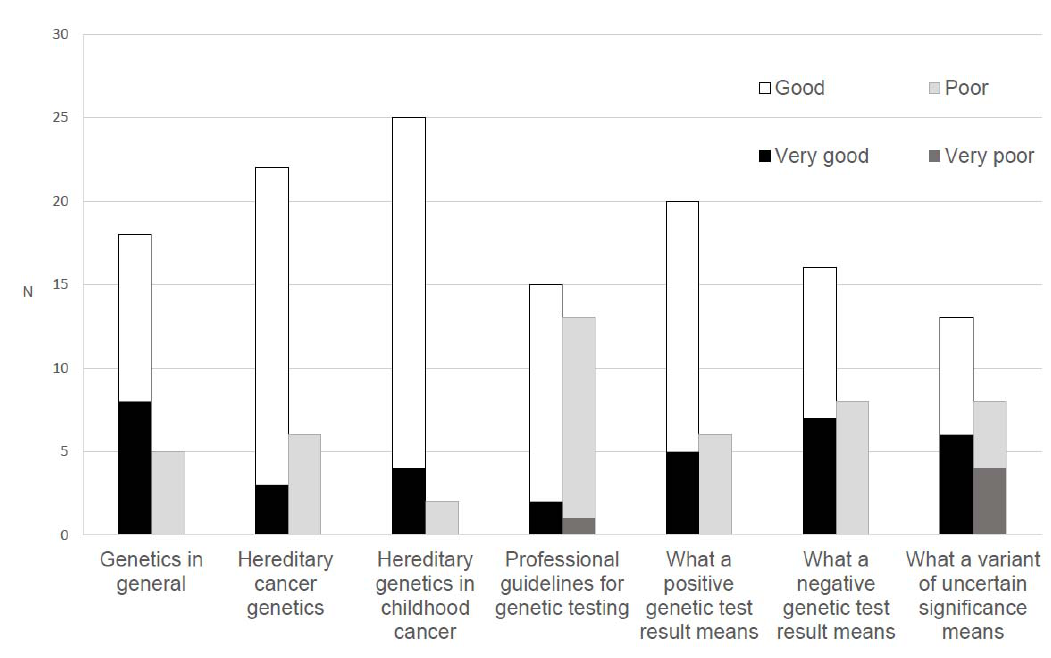
Figure 2. Oncologists’ ( n = 35) ratings of their perceived knowledge of genetics.